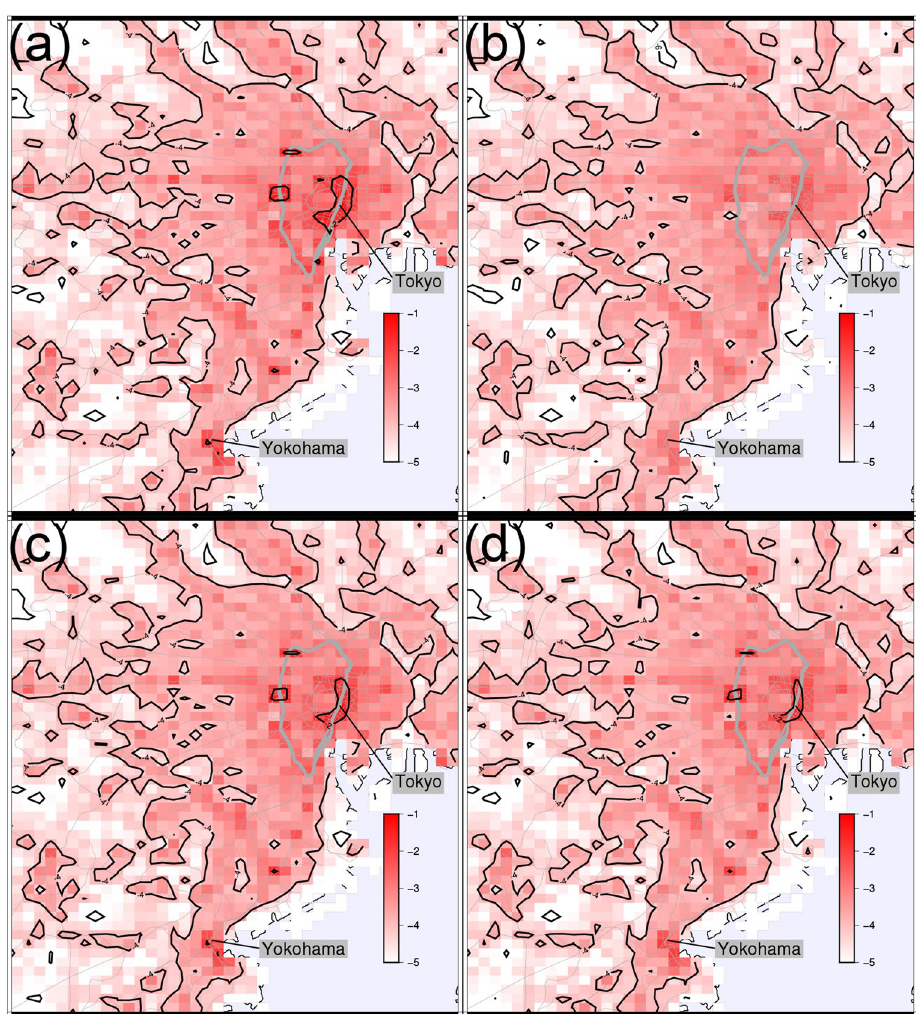
Figure 6. Effective reproduction number map of Tokyo metropolitan area ( a ) 2 months before 1st SoE, ( b ) during 1st SoE, ( c ) 2 months before 2nd SoE, and ( d ) during 2nd SoE. The Yamanote line is indicated by a bold grey closed curve, and other railways are indicated by fine grey curves. The colour represents the values on a log- 10 scale. The sum of all regions is the overall effective reproduction number. High-risk zones are concentrated around Tokyo station and the Yamanote line. The maps are generated by Generic Mapping Tools (GMT) 6.0.0 49 (https:// www. gener ic- mappi ng- tools.